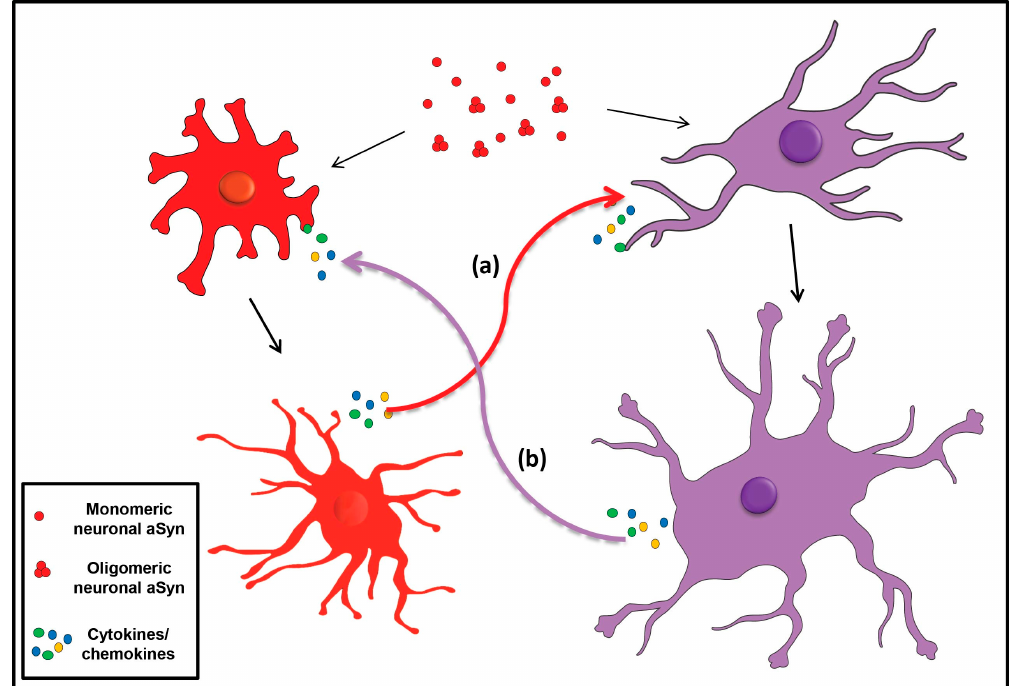
Figure 4. Crosstalk between astrocytes and microglia in a-synucleinopathies. Monomeric or oligomeric aSyn released by neurons is taken-up by astrocytes (purple) and microglia (red), which are then activated and secrete various cytokines or chemokines. (a) According to the prevailing hypothesis, the released pro-inflammatory molecules by microglia trigger the activation of astrocytes (red arrow), leading to excessive inflammation and neurotoxicity. (b) Conversely, aSyn can directly activate astrocytes to secrete pro-inflammatory cytokines or chemokines that recruit and activate microglia (purple arrow) resulting in excessive